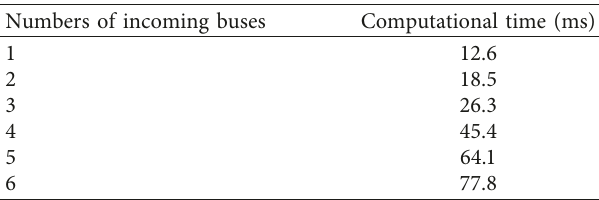
Table 3: Average computational time of solving the model.